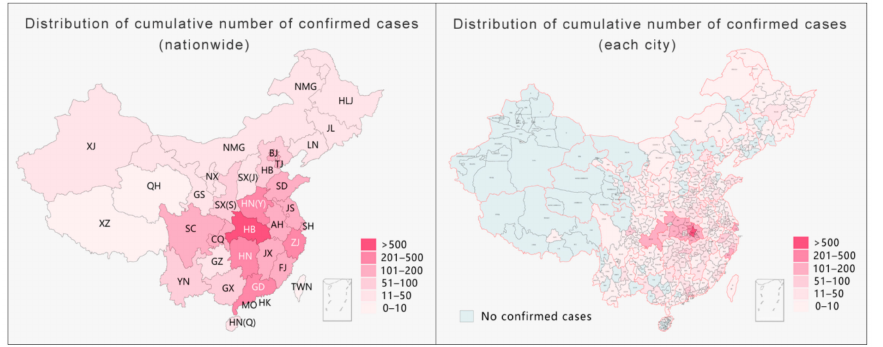
Figure 1. Comparison of the visualization results of the pandemic data at the provincial and munici- pal levels (as of 30 January